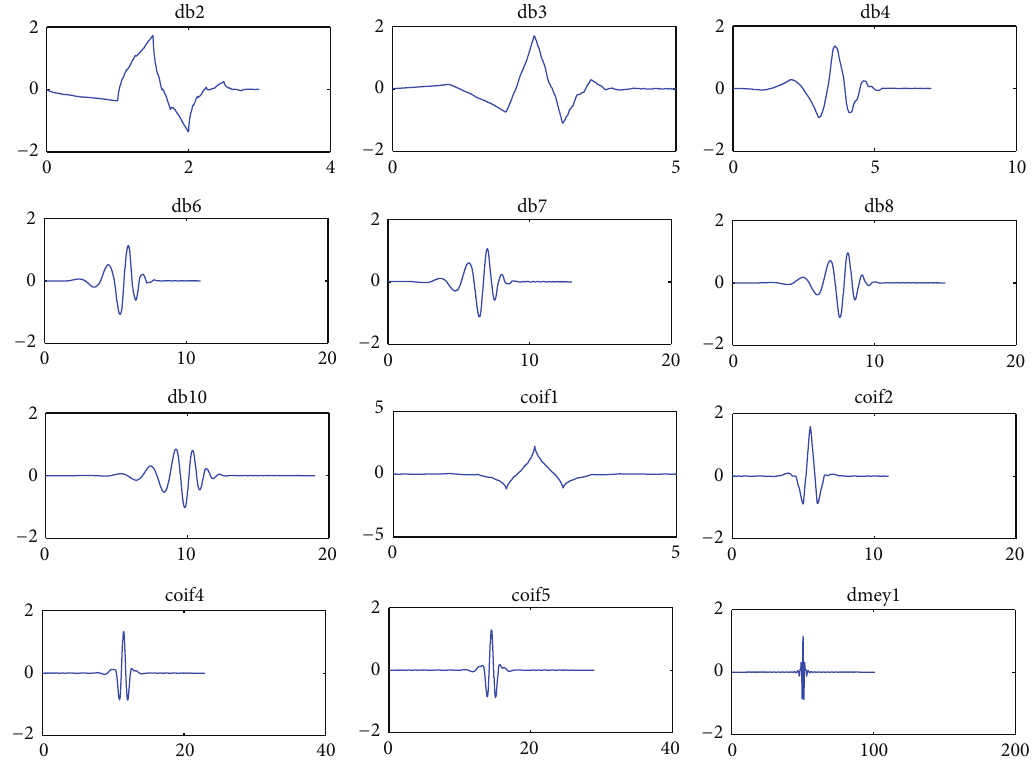
Figure 8: Examples of mother wavelet of Daubechies, coiflets, and dyme.